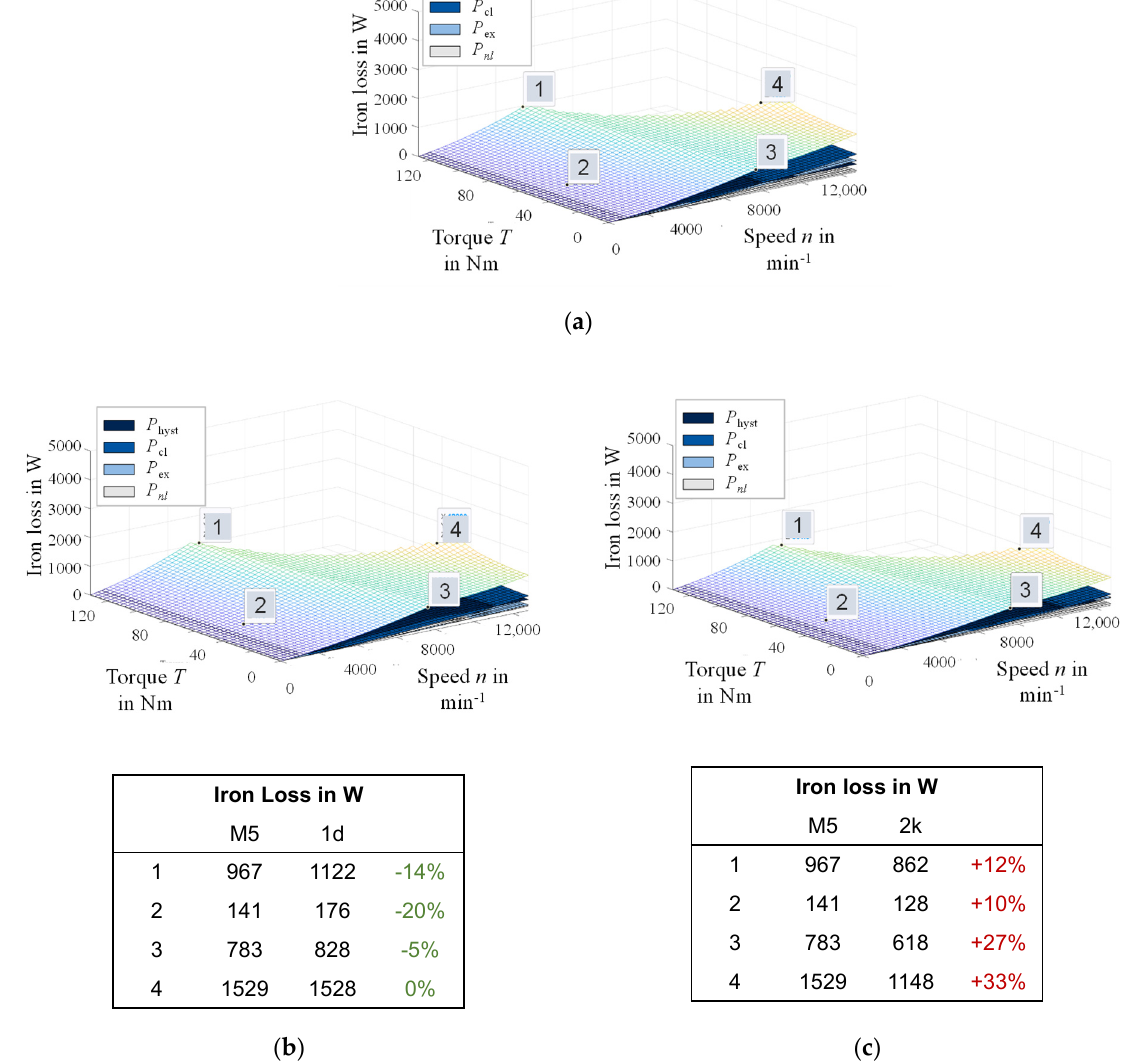
Figure 13. Simulation study results and comparison of the tailor-made material (M5) with two 0.25 mm steel grades in a torque–speed map: ( a ) Tailor-made material, Fe–3.2 wt % Si, 0.3 mm, 80 µm; ( b ) 1d—Fe–2.4 wt % Si, 0.25 mm, 37 µm; ( c ) 2k—Fe–3.2 wt % Si, 0.25 mm, 162 µm.